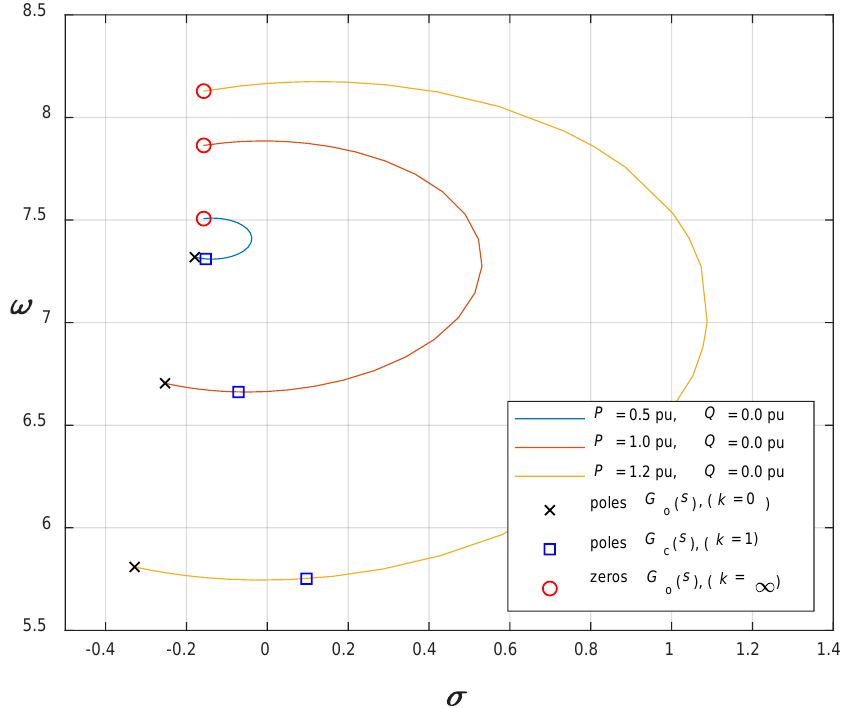
Figure 15. Root locus diagrams of local mode eigenvalue for a hydro-type synchronous generator with nominal power 158 MVA for operating points: (i) P = 0.5 pu, Q = 0.0 pu, (ii) P = 1.0 pu, Q = 0.0 pu and (iii) P = 1.2 pu, Q = 0.0 pu.